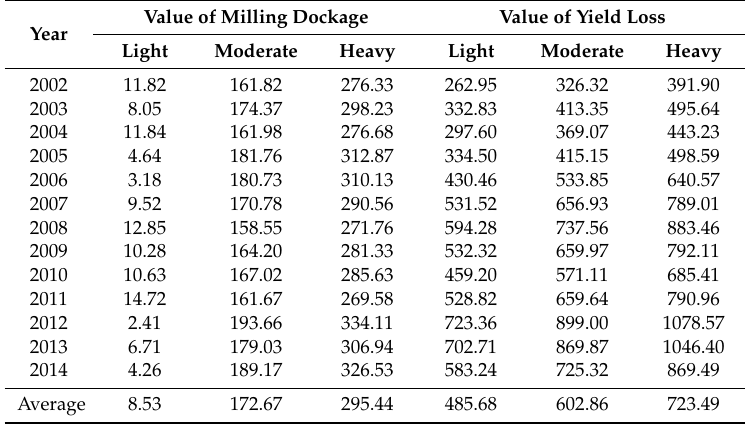
rice types under the light, moderate, and heavy levels of initial red rice infestation: